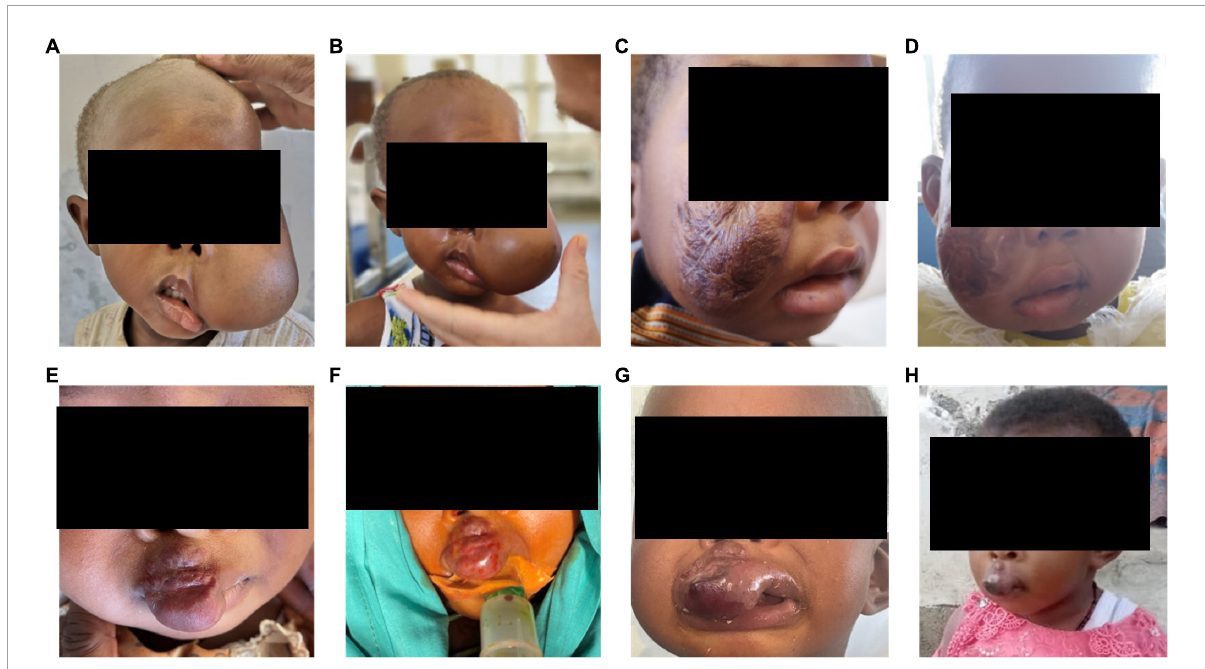
FIGURE3 (A) Pre-procedural images of a 2-year-old girl who presented to the VA clinic with left cheek swelling due to a VM of the left cheek and face with involvement of the lateral border of the left eye. (B) Post-interventional swelling occurred in this patient as expected. (C) Pre-procedural images of a 3-year-old girl with a VM of the right cheek, the patient underwent prior traditional medicine treatment leaving extensive scars on the right cheek. (D) Post-interventional swelling occurred as expected in this patient. (E,F) Pre- and intra-procedural images of a 2-year-old girl with a VM on the upper lip extending up to the right nostril. (G) After the procedure a swelling occurred, and a slight dark discoloration demarcated on the lip. (H) The small necrosis healed quickly and the proportion below the right nostril already shrunk significantly. All patients need further treatment sessions and close follow-up. VA = vascular